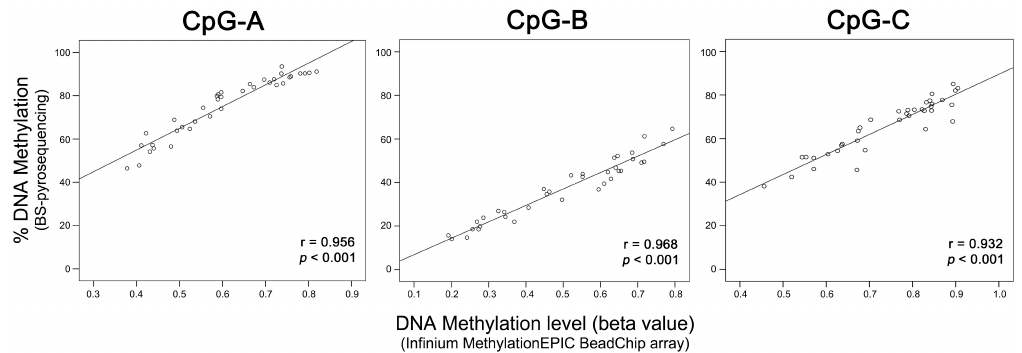
Figure 4. Correlation between the methylation levels of the three CpGs of LARC samples determined by microarray (Infinium MethylationEPIC BeadChip array, Illumina) and bisulfite (BS) pyrosequencing analysis. The scatterplots show a high positive correlation for three CpGs identified as a predictive classifier of response to neoadjuvant chemoradiotherapy. ( r ) Pearson's correlation coefficient, ( p ) p -value from Pearson's correlation test. from Pearson’s correlation